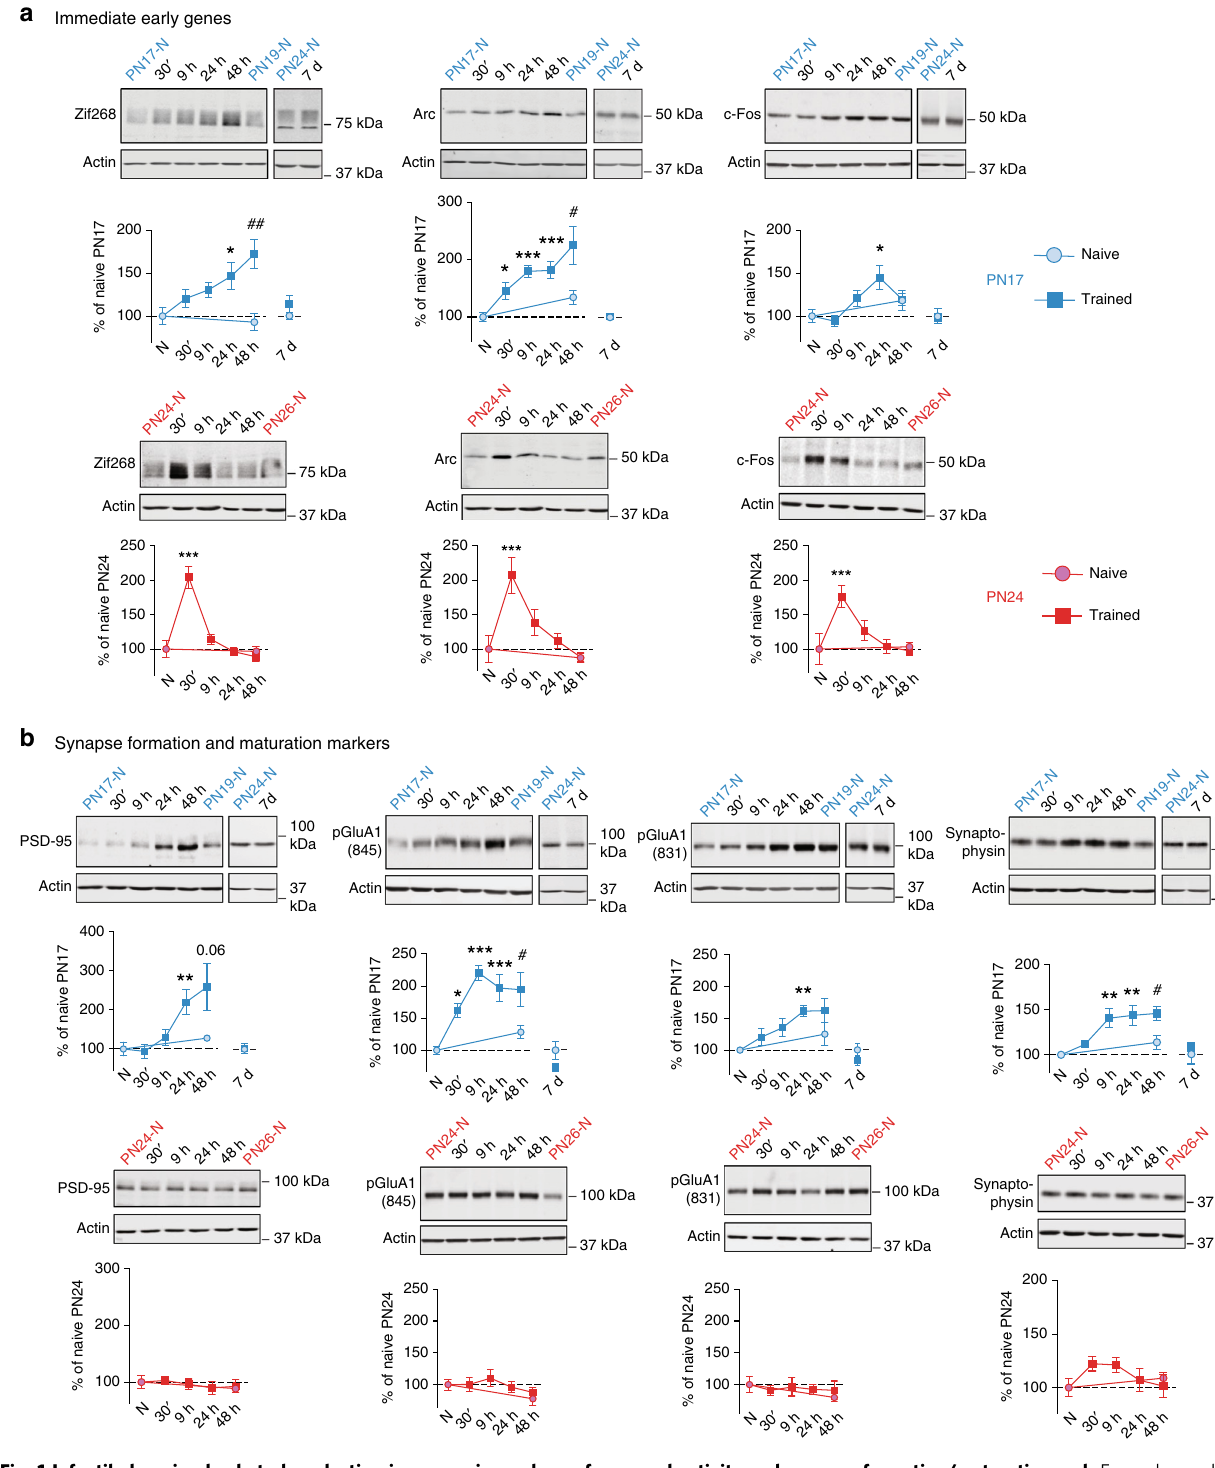
Fig. 1 Infantile learning leads to long-lasting increases in markers of neuronal activity and synapse formation/maturation. a , b Examples and densitometric western blot analyses of dHC whole-protein extracts obtained from rats trained in IA at PN17 (blue) or PN24 (red) and euthanized 30 min, 9 h, 24 h, 48 h, or 7 days after training ( n = 4 – 10 rats per group). To account for developmental differences, four groups of naive rats were used: PN17 ( n = 6 – 8) and PN19 ( n = 6) or PN24 ( n = 4 – 8) and PN26 ( n = 6 – 7). a Immediate early genes: Zif268, Arc, and c-Fos. b Synapse formation/maturation markers: PSD-95, pGluA1(845), pGluA1(831), and synaptophysin. Actin was used as a loading control. Data are expressed as mean percentage ± s.e.m. of the value in the corresponding naive group (N). * P < 0.05, ** P < 0.01, *** P < 0.001: signi fi cance compared with PN17 or PN24 naive rats (one-way ANOVA followed by Dunnett ’ s multiple comparisons test); # P < 0.05, ## P < 0.01: signi fi cance comparing PN19 naive rats to 48 -h trained groups (two-tailed unpaired Student ’ s t test). The hippocampal extracts collected 7 days after training at PN17 were analyzed separately from the other time points, and the levels of expression of the different markers were normalized on those measured in naive rats euthanized at PN24 to account for developmental differences (two- tailed unpaired Student ’ s t test). For detailed statistical information, see Supplementary Table